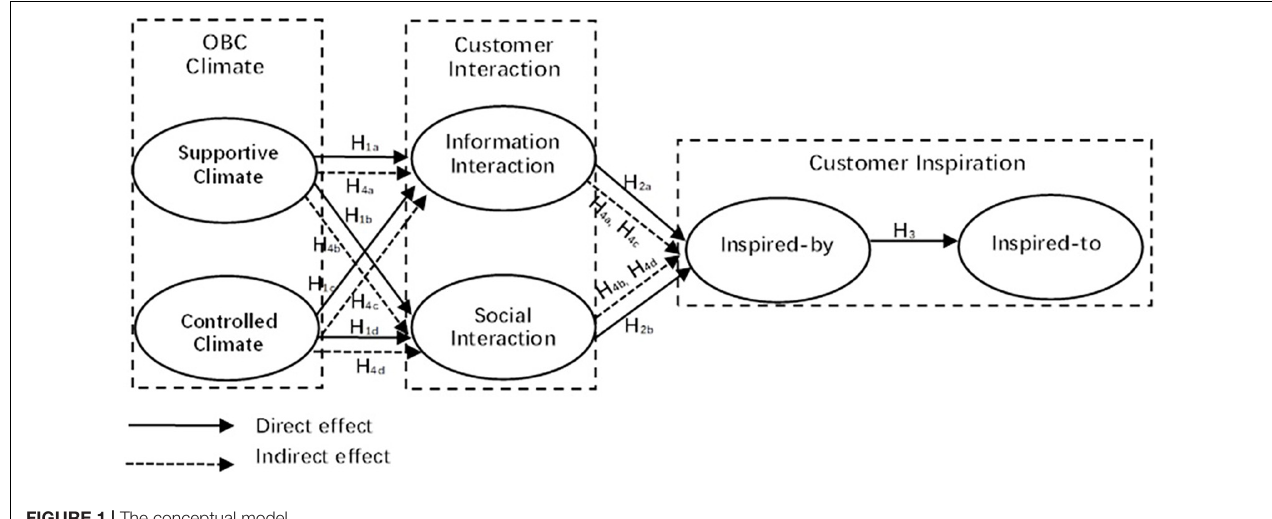
FIGURE 1 | The conceptual